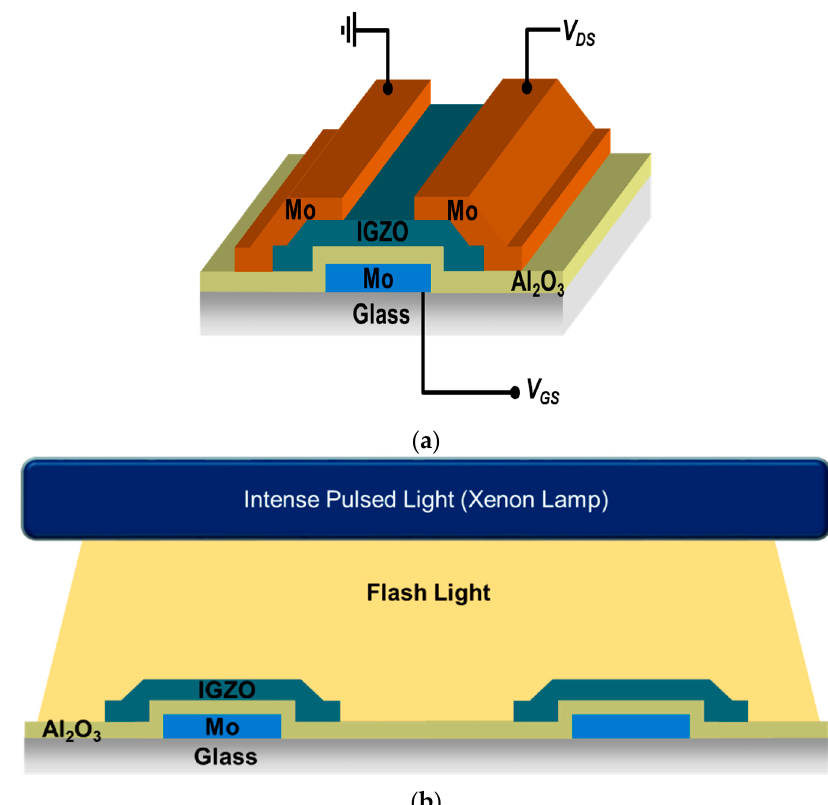
Figure 1. Schematic diagrams of ( a ) In-Ga-Zn-O (IGZO) thin film transistor device with inverted-staggered structure and ( b ) intense pulsed light (IPL) rapid annealing system with xenon flash lamp.